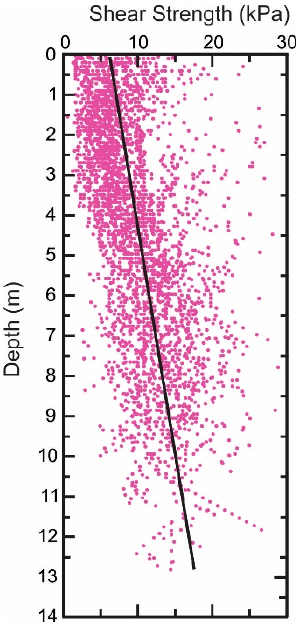
Figure 4. Aggregate of undrained shear strength for all cores used in this study. The trend line (in black) is defined by S u = 0.93 z + 6.30 (R 2 = 0.18).